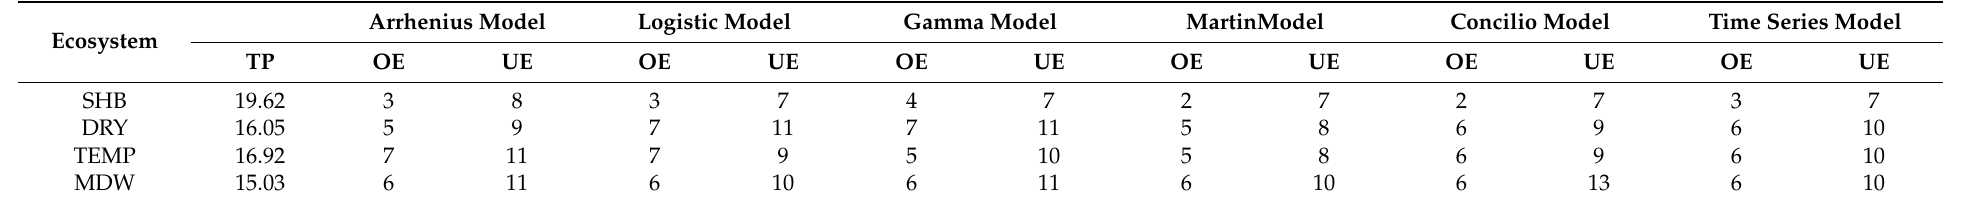
Table 3. Comparison of percentage of predicted values outside the 95% confidence intervals. OE, percentage of overestimated values (%); UE, percentage of underestimated values (%); TP, threshold point ( ◦ C), when Ts exceeds this value, R eco tends to